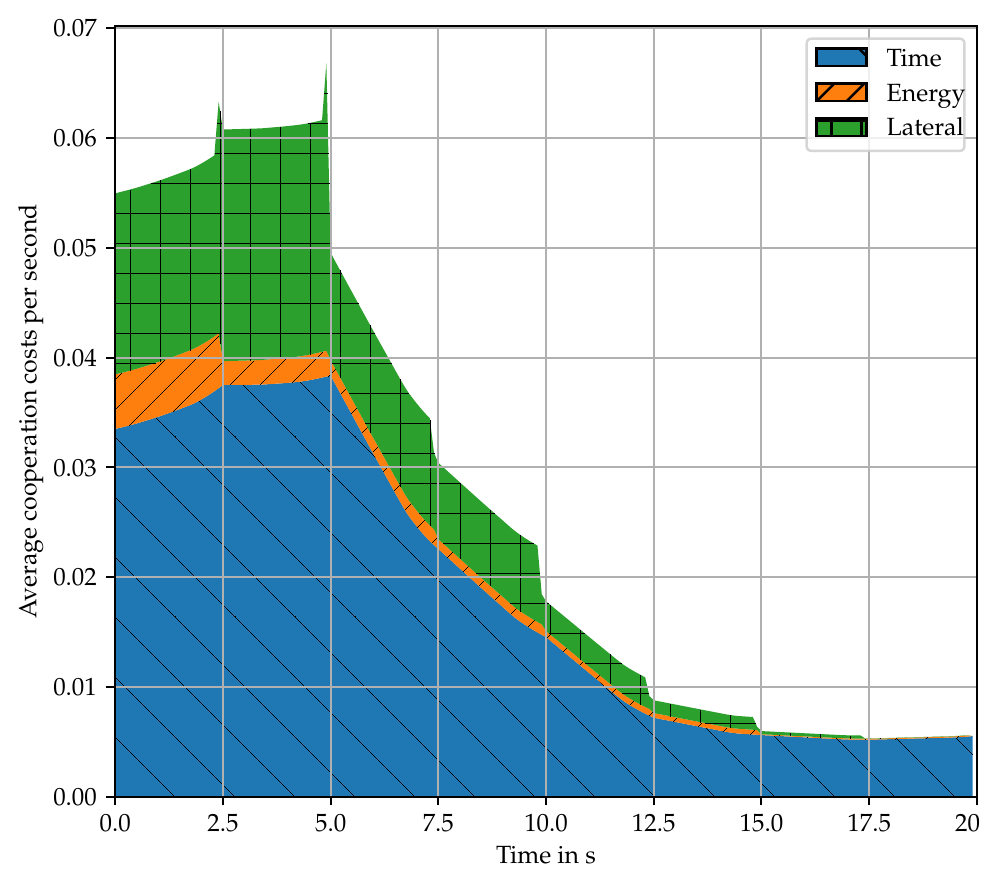
Figure A1. Costs over time for global